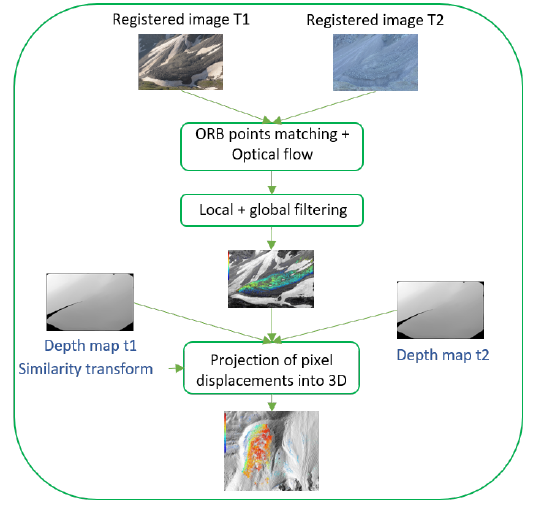
Figure 3. a) : Vector field pipeline: corresponding pixels in images taken at different time within one view are computed by ORB keypoint matching and refined by optical flow. The result is filtered to enforce a local coherence in norm and direction. Then depth maps are used to remove the perspective effect on the displacement field. Finally the similarity transform calculated in the calibration step is used to scale and georeference the displacement vector field.